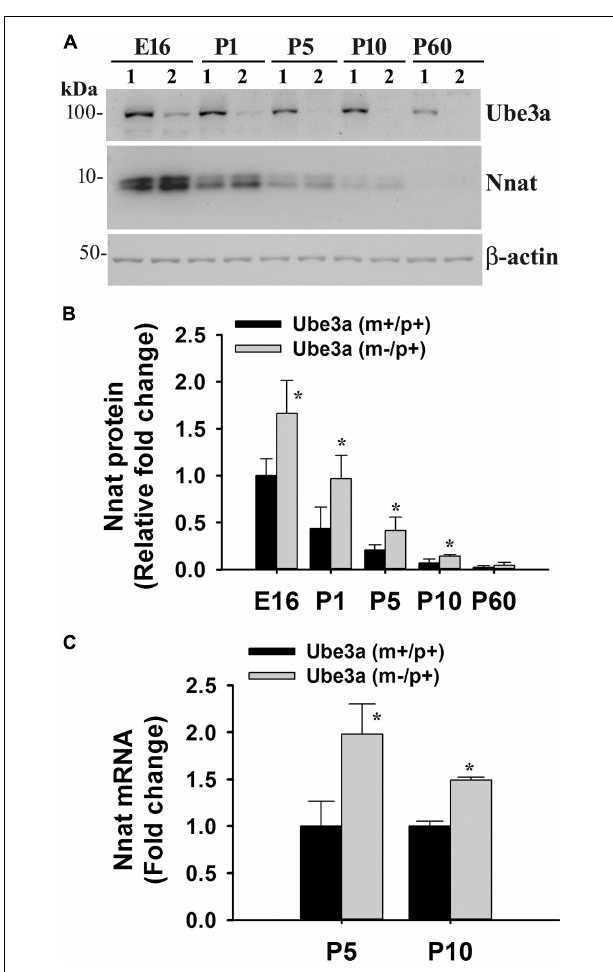
FIGURE 4 | Comparative analysis of immunofluorescence staining of Nnat in various brain regions between wild type and AS mice at postnatal day P5 and P60. (A) Typical immunofluorescence staining of Nnat in the cortical and hippocampal region of wild type and AS mice. (B) Double immunofluorescence staining of Nnat and PV in the brain section obtained from 60 days old (P60) wild type and AS mice. Note the selective localization of Nnat in PV neurons (indicated by arrow). Arrowhead points the Nnat stained neuron that is not localized with PV neuron. Brain sections obtained from both wild type and AS mice were kept on the same slide and processed for immunostaining. Scale: 20 µ